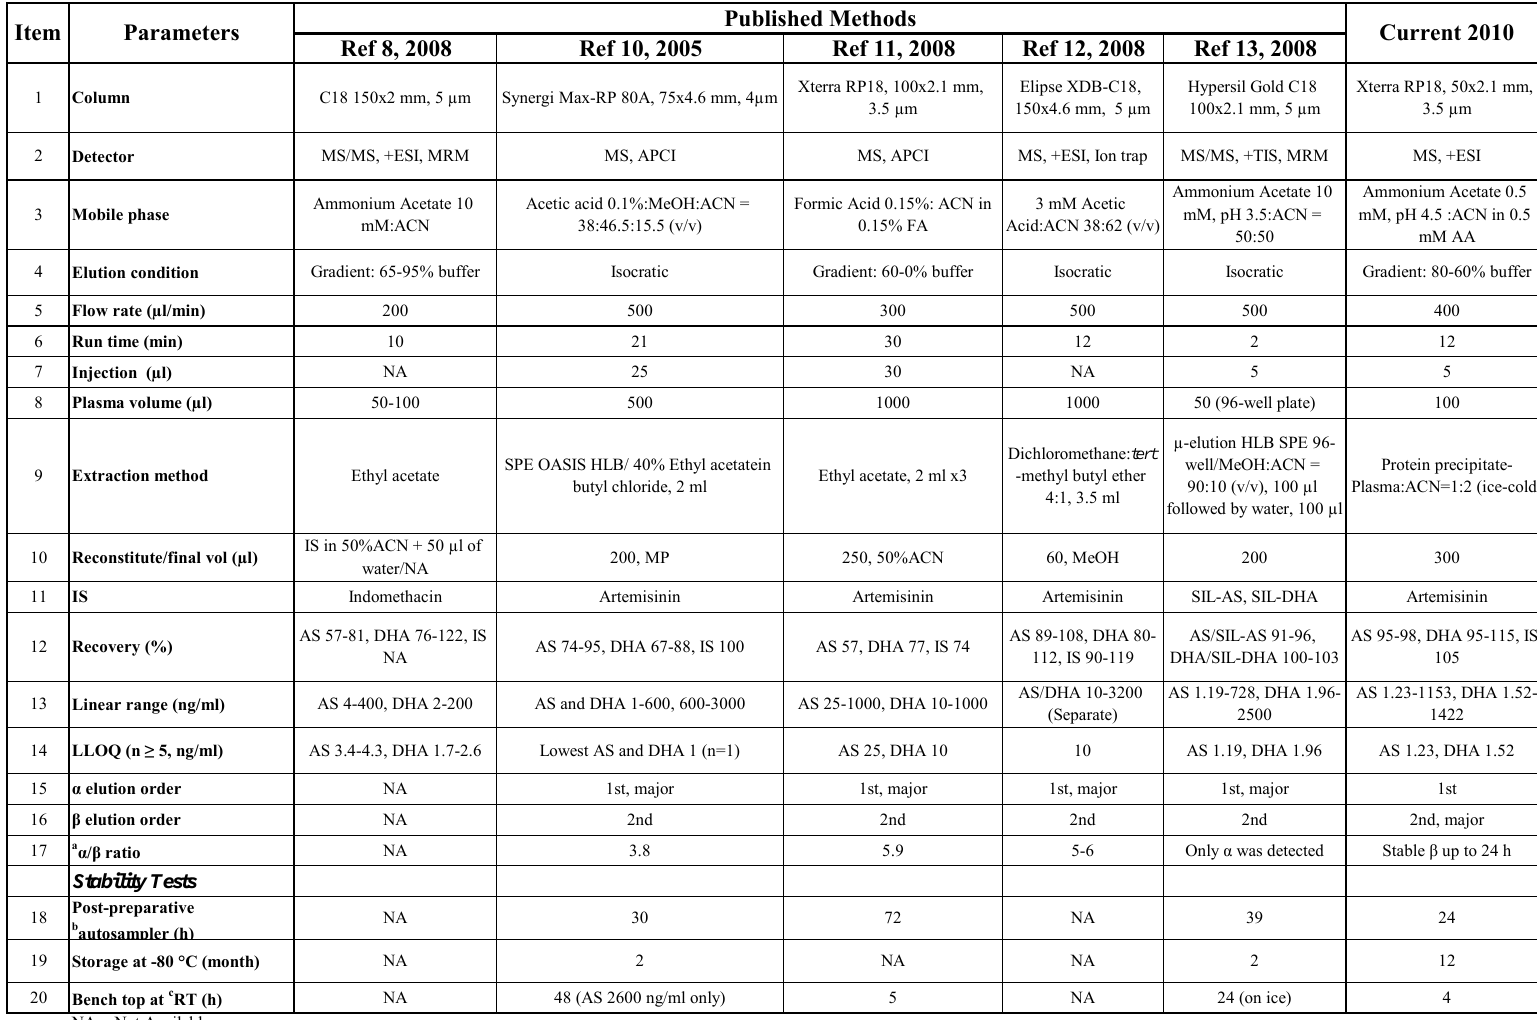
Table 2. Summary of recent analyses of AS and DHA in human plasma using LC-MS or LC-MS/MS compared to current